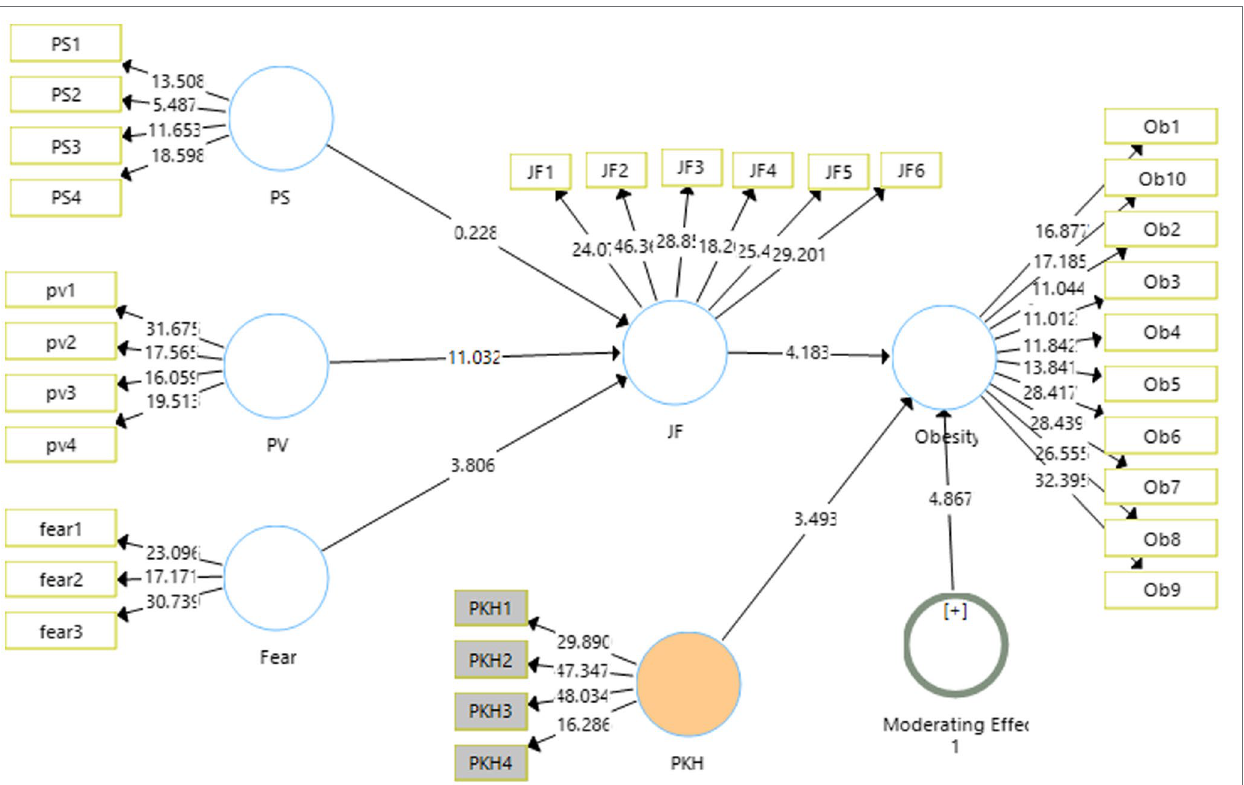
FIGURE 4 | Output of structural model with moderation. PS, perceived severity; PV, perceived vulnerability; JF, junk food eating behavior; PKH, product knowledge